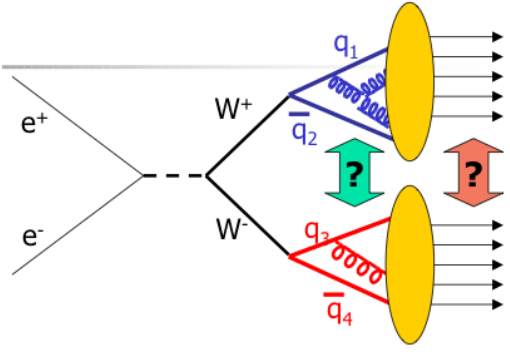
Figure 3. The e ff ects of CR for WW bosons in the string hadronization models